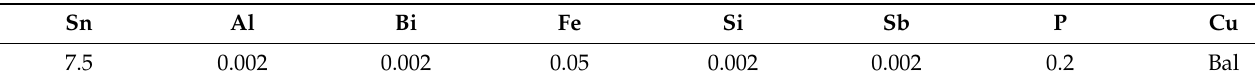
Table 1. Chemical composition of the Cu-Sn-P alloy (wt. %).